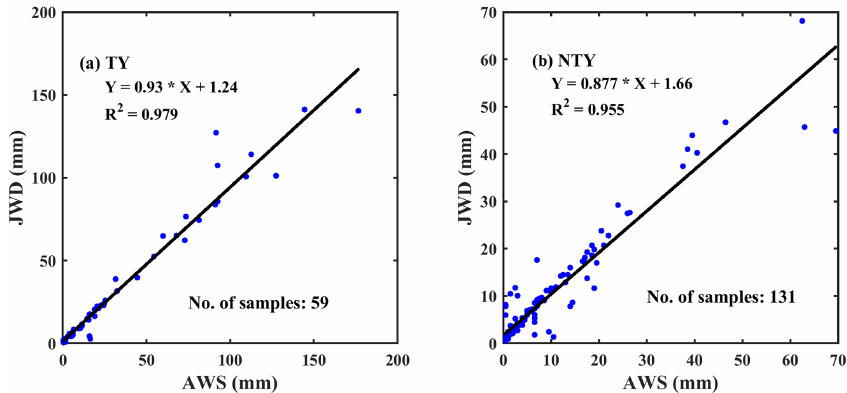
Figure 2. The JWD and rain gauge daily accumulations scatterplot for (a) typhoon (TY) and (b) non-typhoon (NTY) rainfall.